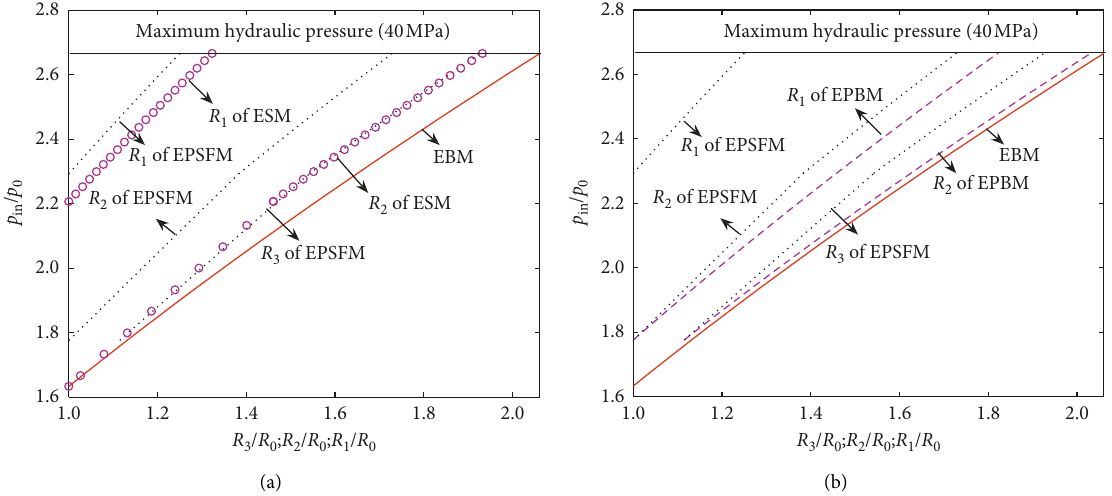
Figure 5: The radii distribution laws for circular opening expansion.